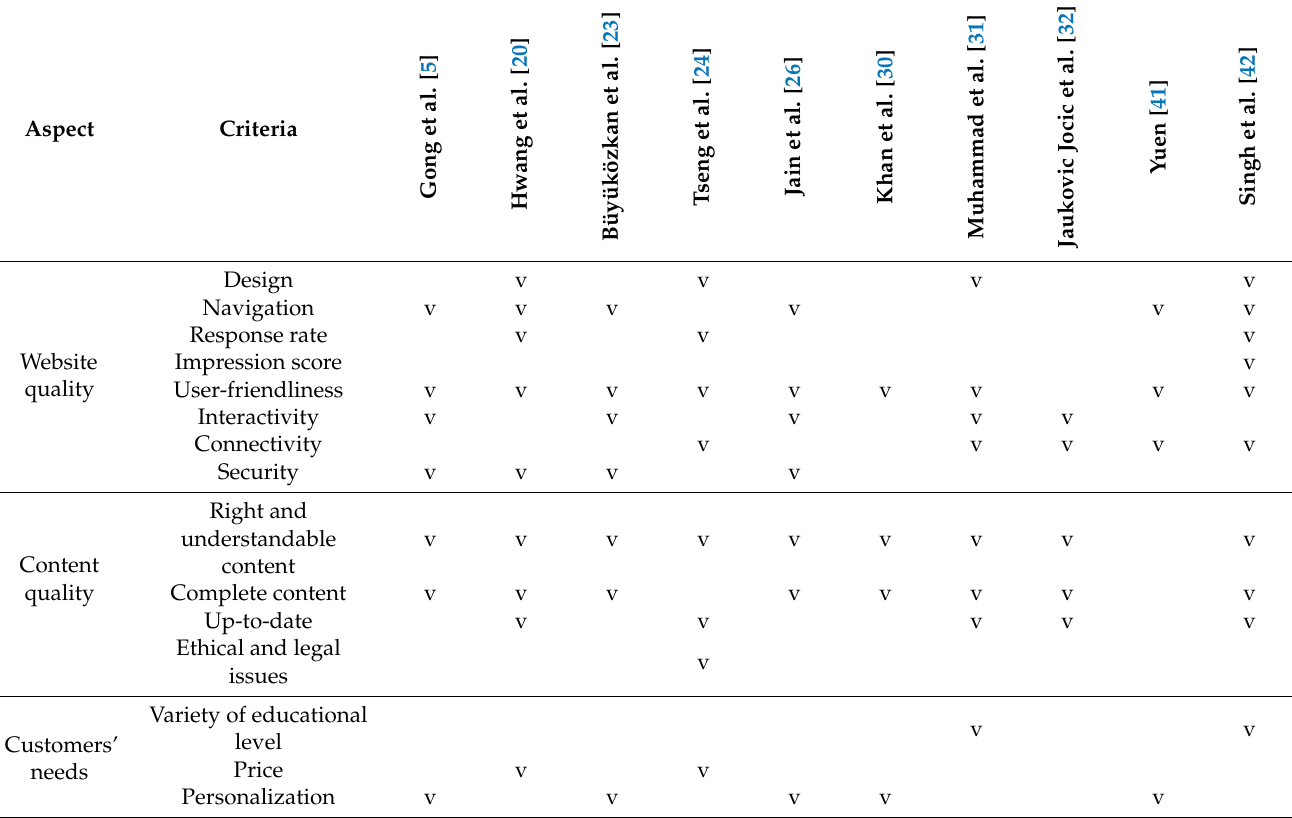
Table 4. Summary of criteria considered from the previous